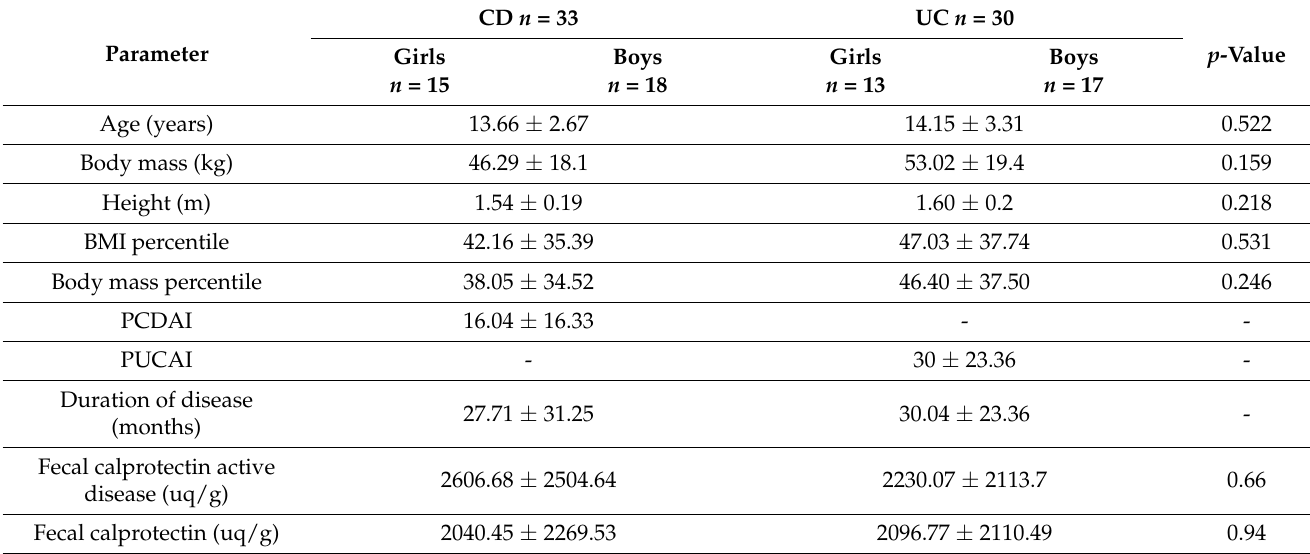
Table 1. Characteristics of patients with CD and UC.